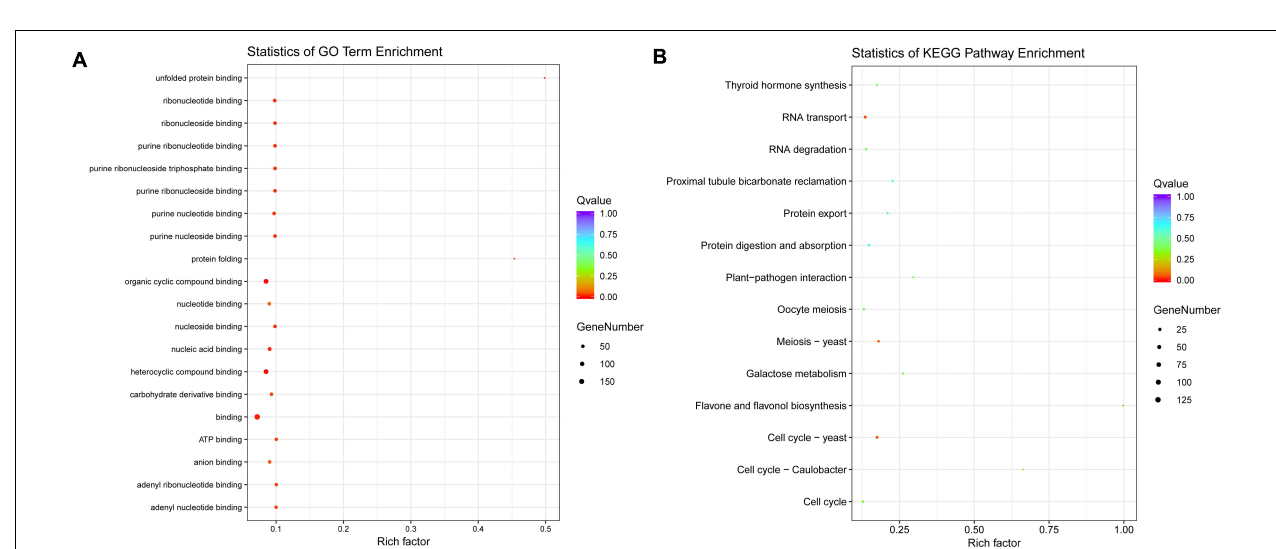
FIGURE 7 | Functional annotation of the genes with AS events. (A) GO term enrichment, (B) KEGG pathway enrichment.